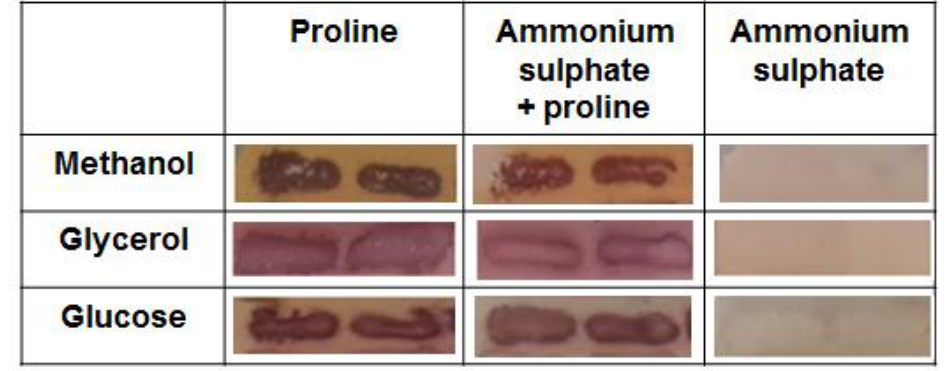
Figure 1. Photographs of K. phaffii P1AP-GS115 strain colonies grown on media with different carbon and nitrogen sources illustrate the results of the qualitative analysis of ACP reporter system